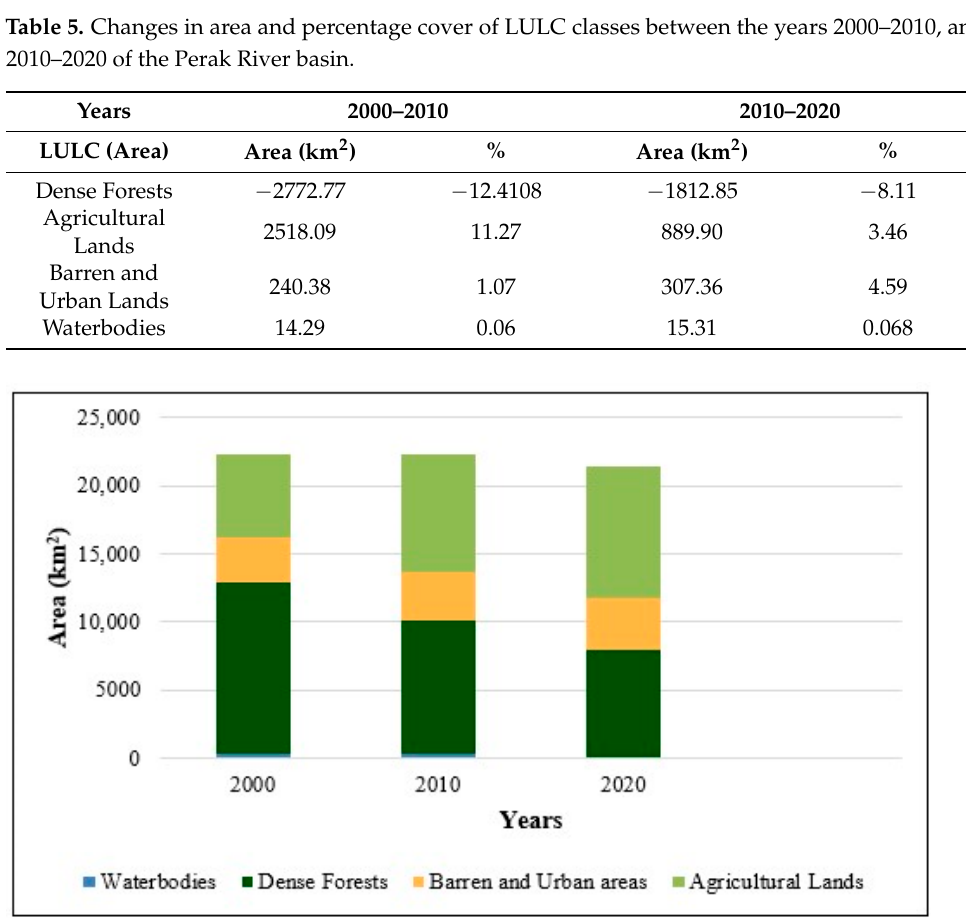
Figure 7. LULC change graph for 2000, 2010, and 2020 for Perak River basin.